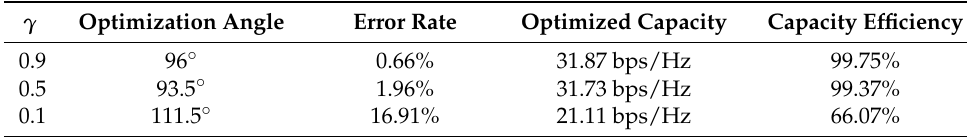
Table 13. Optimized values for antenna downtilt and channel capacity with different discount rates at D = 250